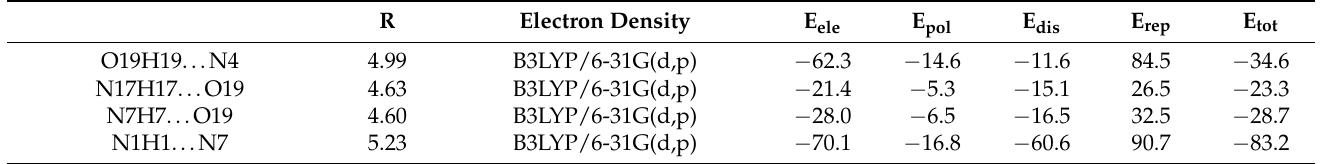
Table 2. Interaction energies (kJ/mol) computed using single crystal geometries. R Electron